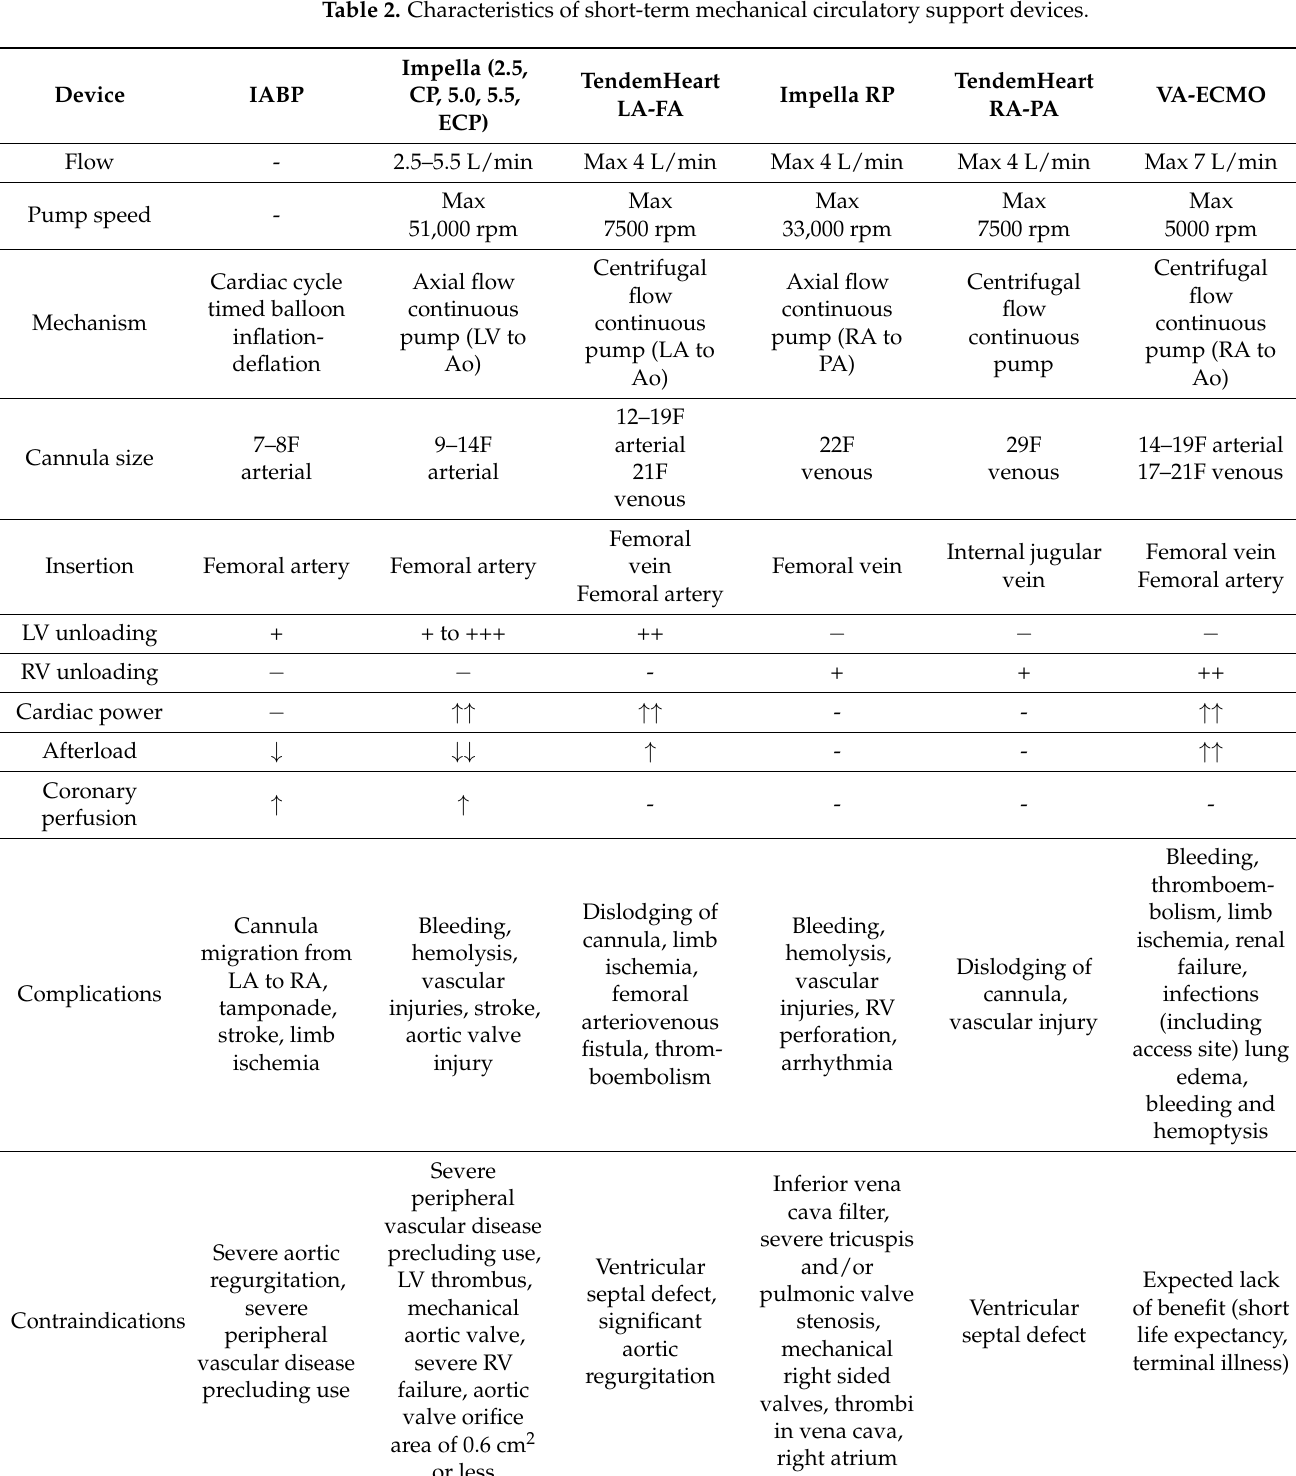
Table 2. Characteristics of short-term mechanical circulatory support